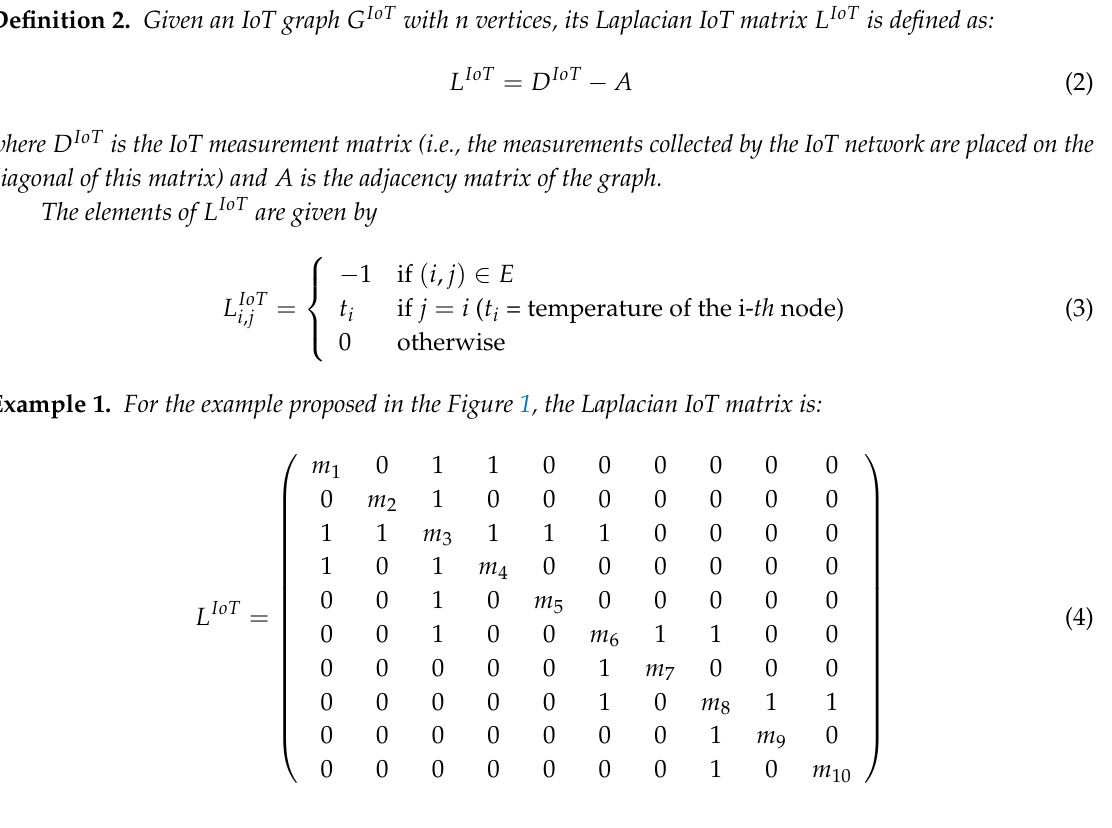
Figure 1. Illustrative example of how the construction of a graph is based on the position of the IoT nodes on a map. On the top of the figure is a floor plan of the building with IoT devices placed to collect data. On the bottom there is the IoT Graph linked with the IoT system. The Spectral Graph Theory can be applied to support us to provide a solution to the problem of stability in IoT